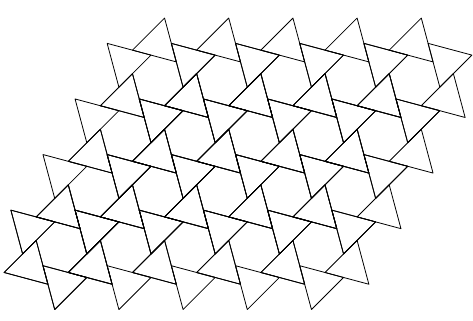
Fig. 49: Tiling with regular hexagon and regu- lar triangle. The edge of the hexagon is longer (D).